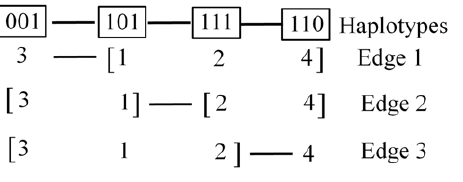
Figure 4. Illustration of tree topology example described in